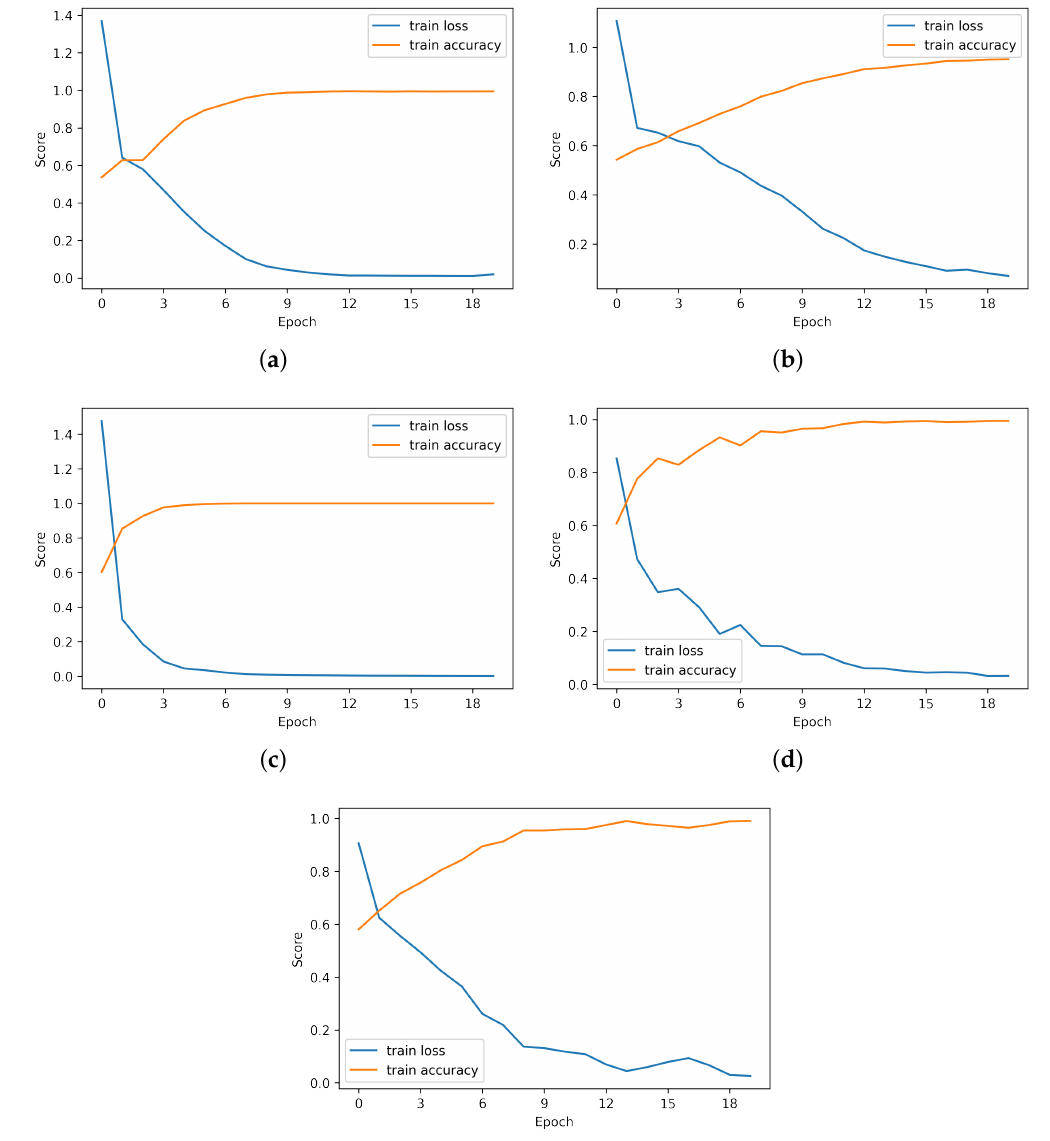
Figure 4. The time-series analysis of the employed neural network approaches with each epoch during training. ( a ) The loss and accuracy analysis of the NAS-Net approach. ( b ) The loss and accuracy analysis of the Xception approach. ( c ) The loss and accuracy analysis of the Mobile Net approach. ( d ) The loss and accuracy analysis of the VGG16 approach. ( e ) The loss and accuracy analysis of the proposed